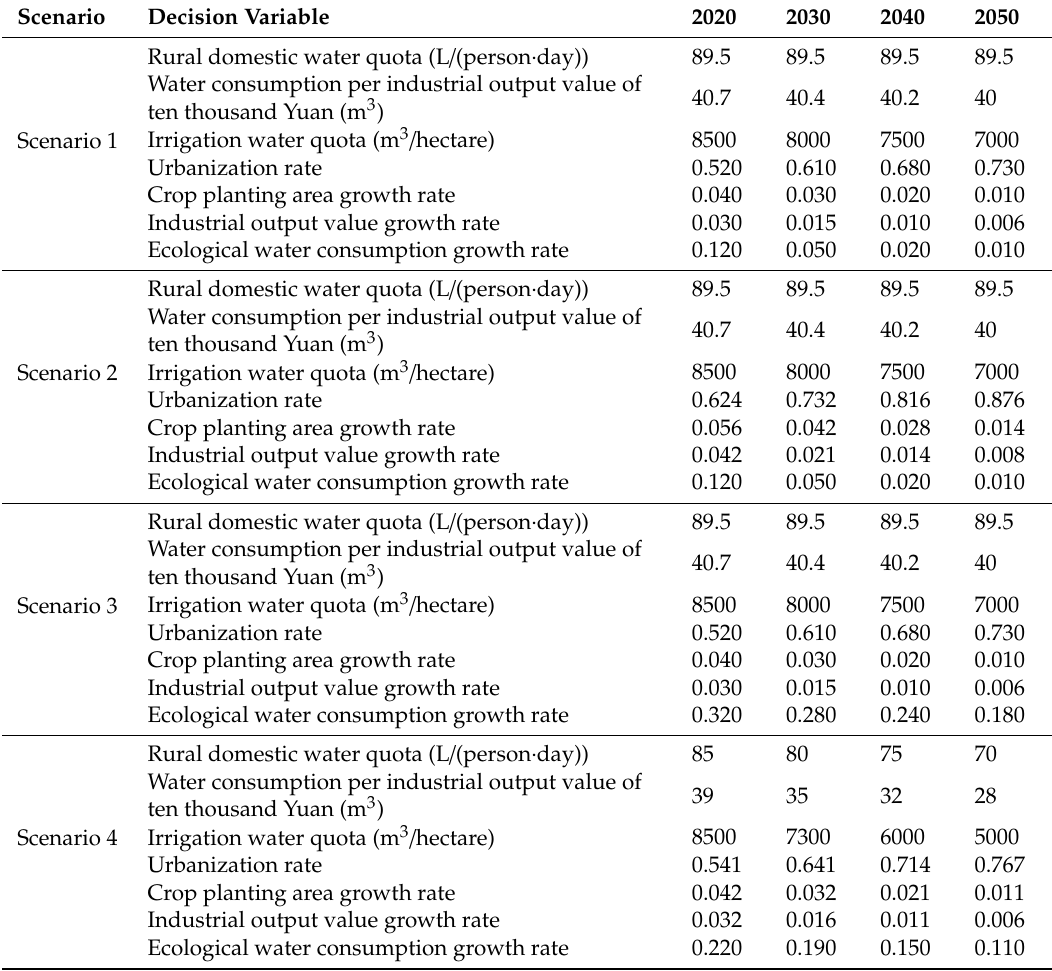
Table 3. Values of decision variables under di ff erent scenarios for